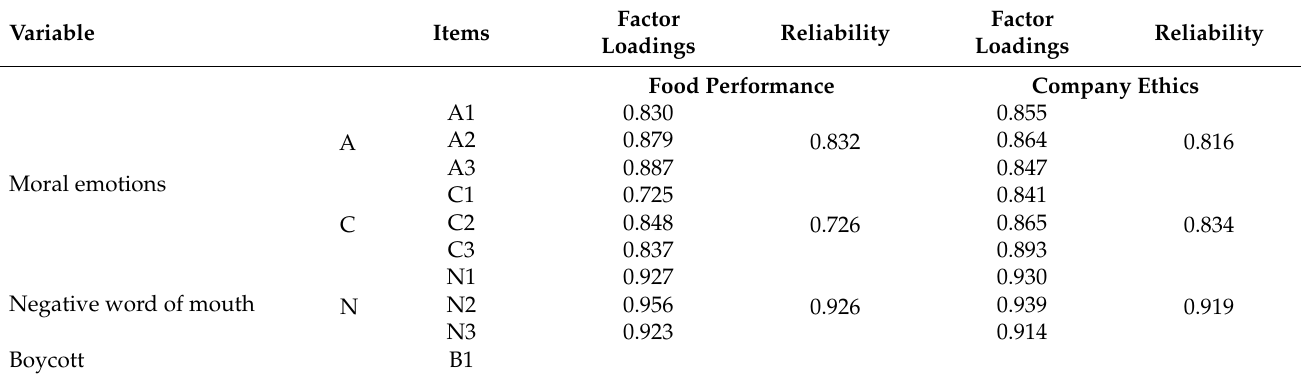
Table 3. Factor loading and reliability of each variable and item.